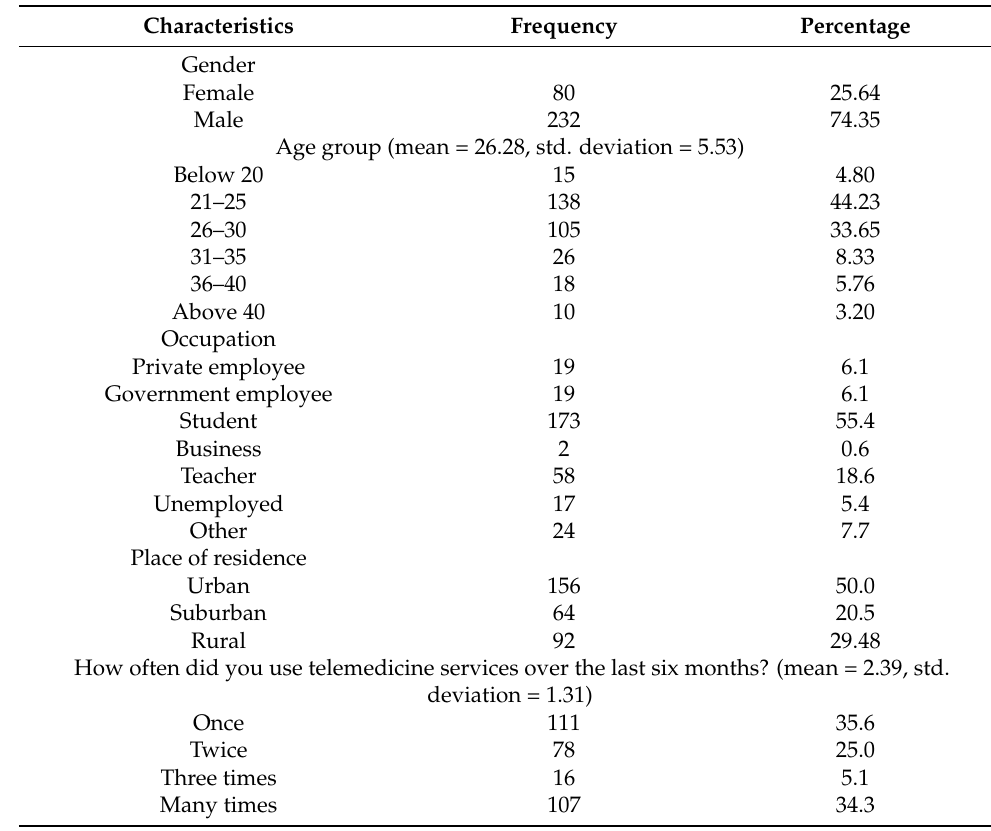
Table 2. Demographic statistics ( n =